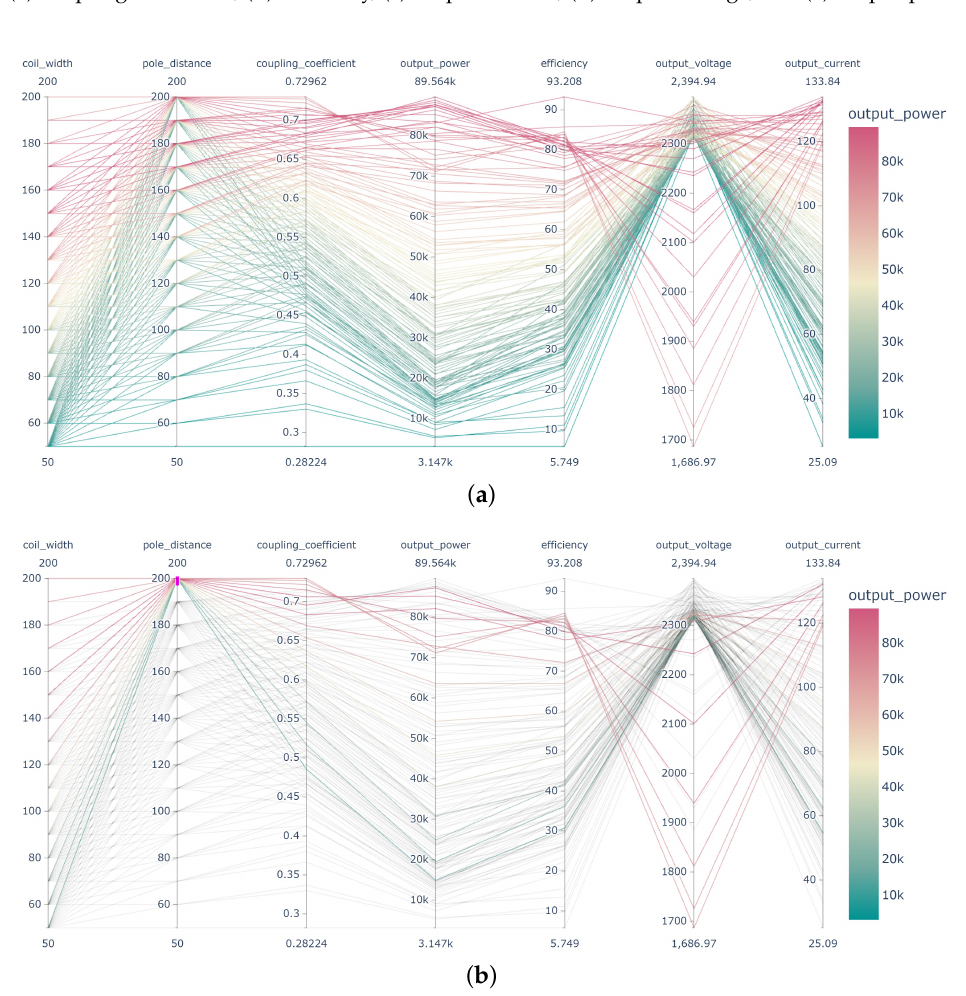
Figure 10. PCP of grid analysis example as ( a ) overall display and ( b ) highlight